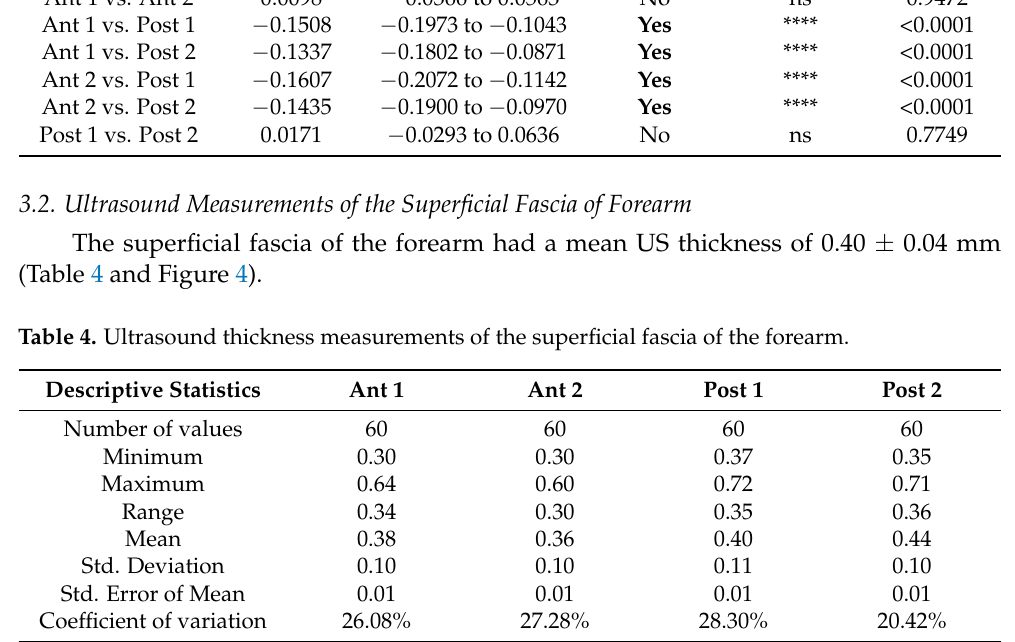
Table 4. Ultrasound thickness measurements of the superficial fascia of the forearm. Descriptive Statistics